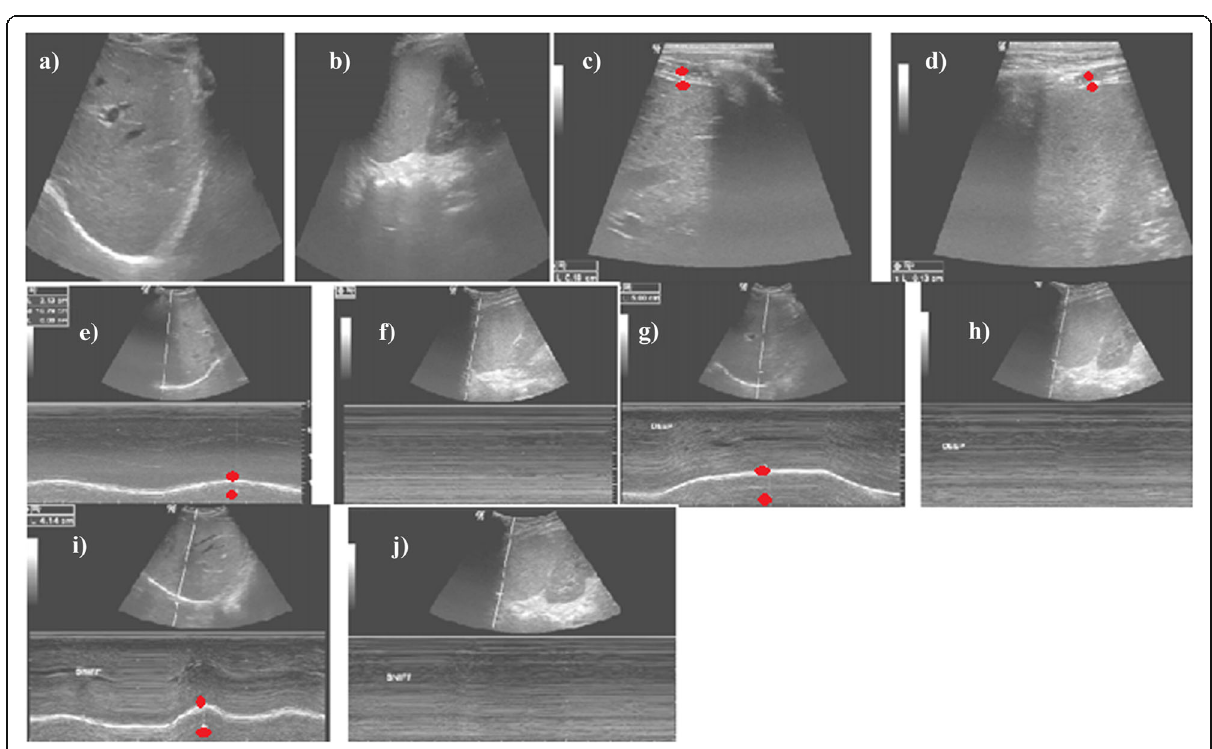
Fig. 5 a – j US images for a 52-year-old male patient with a history of cardiothoracic surgery 6 months ago presented with elevated left copula of the diaphragm in his CT. a , b US images — anterior subcostal view ( a ) and intercostals view ( b ) showing normal US appearance of both hemidiaphragms with no defect detected on either side. c , d US image using superficial probe through an intercostal view showing a diaphragmatic thickness (RT = 1.9 mm ( c , between the red dots)/LT = 1.3 mm {thin, atrophic } ( d , between the red dots)) with a thickening fraction (RT = 45%/LT = 10%). e – j Anterior subcostal and intercostal views used for assessment of diaphragmatic excursion (RT = 2.1 cm in normal breathing ( e , between red dots)/= 5 cm in deep breathing ( g , between the red dots)/=4 cm in sniffing ( i , between the red dots) and the left side showed absent movement in normal ( f ), deep breathing ( h ), and sniffing ( j ). Findings were consistent with left